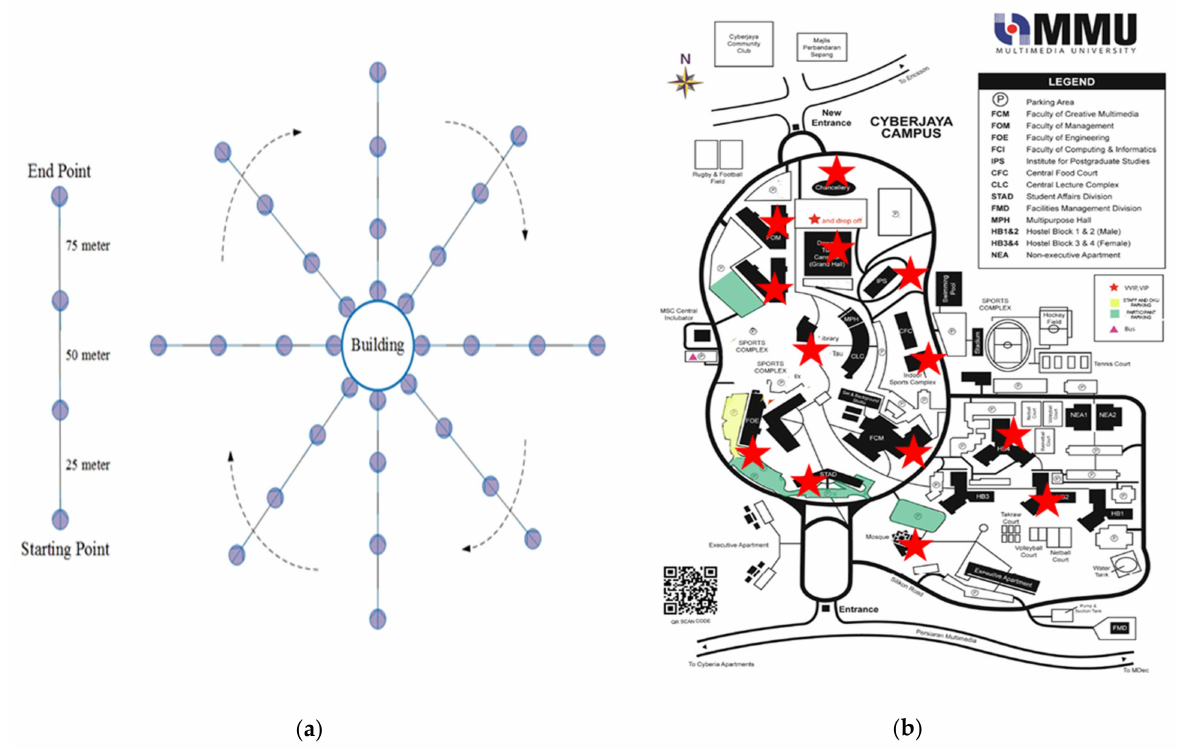
Figure 2. ( a ) The proposed strategy of RF spectral survey for each survey point, ( b ) map of the MMU area indicated RF survey points